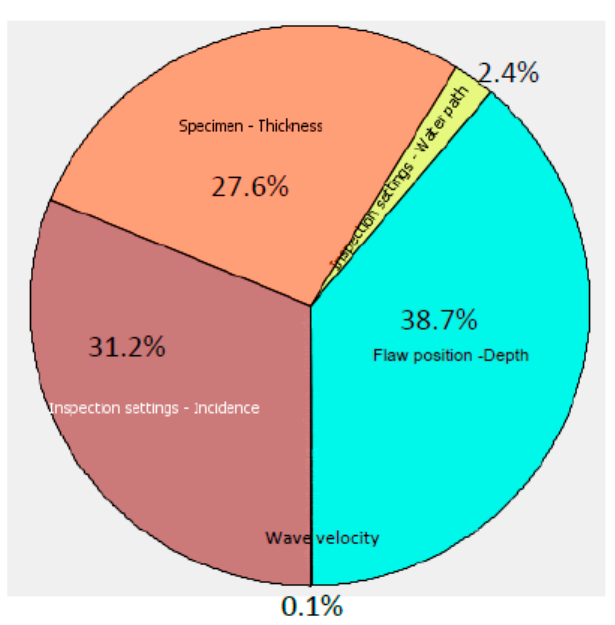
Figure 5. Sensitivity analysis of inspection and defect